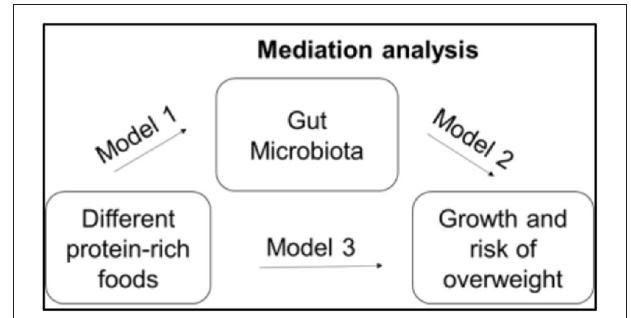
FIGURE 2 | Mediation